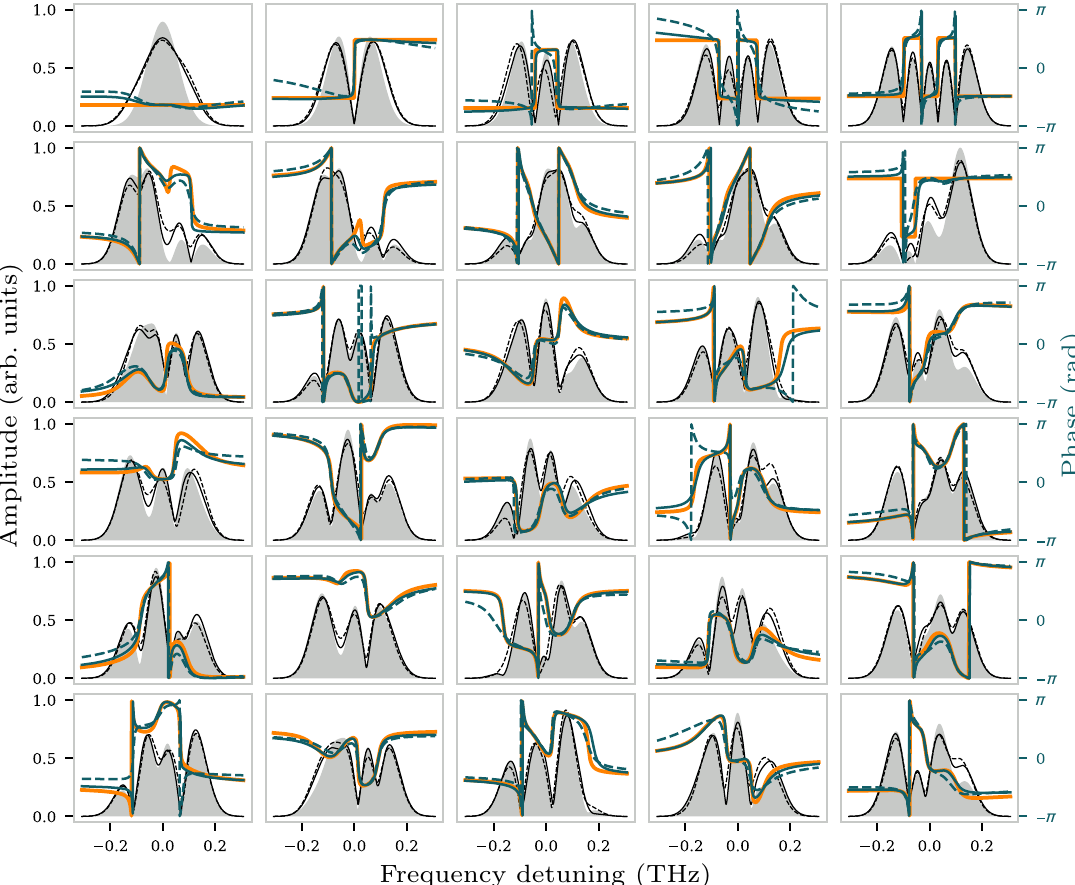
FIG. 5. First eigenmodes of the POVM elements (five for each of the six MUBs). Shaded areas and orange lines show the ideal amplitude and phase; black and blue lines show the same values for experimental data, with solid and dashed lines corresponding to the CCD spectrograph and the TOF spectrograph,